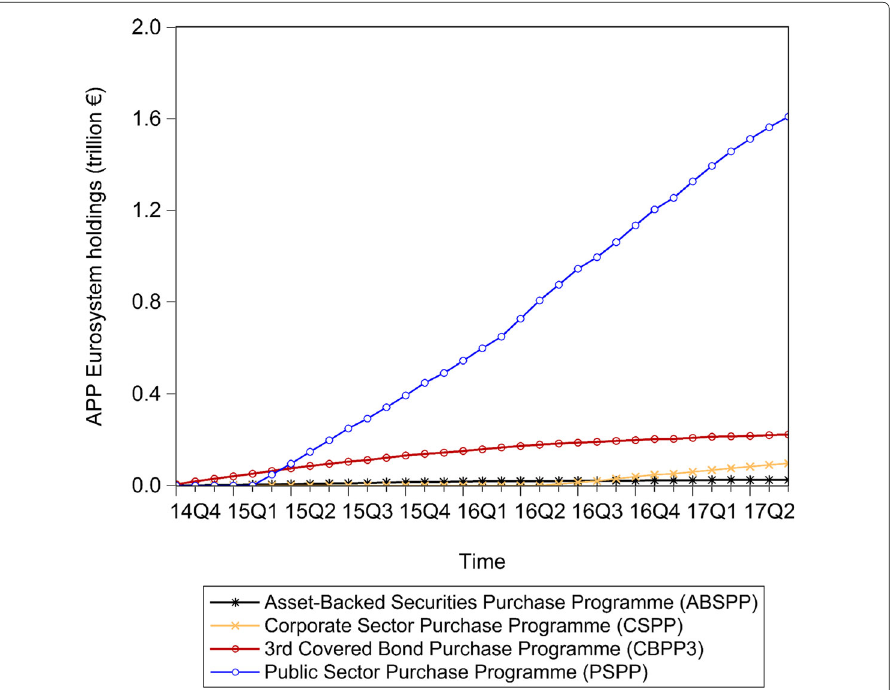
Fig. 10 Eurosystem APP holdings - breakdown by purchase programme; 2014Q4-2017Q2. Time series of the breakdown of the Eurosystem APP holdings in the different programmes included in the APP: i) 3rd Covered Bond Purchase Programme (CBPP3, in dark red), ii) Asset-Backed Securities Purchase Programme (ABSPP, in black), iii) Public Sector Purchase Programme (PSPP, in blue), and iv) Corporate Sector Purchase Programme (CSPP, in yellow), over the reference period 2014Q4-2017Q2. Data Source: (European Central Bank